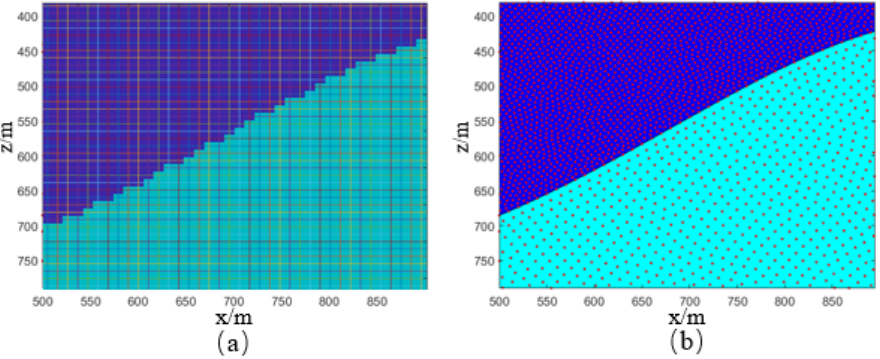
Figure 11. Local grid (node) distribution: ( a ) staggered grid finite difference method, ( b ) generalized finite difference method.